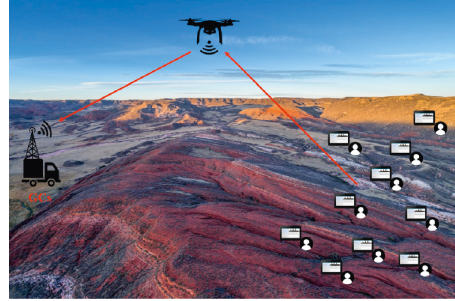
Figure 1: UAV acting as a relay node.